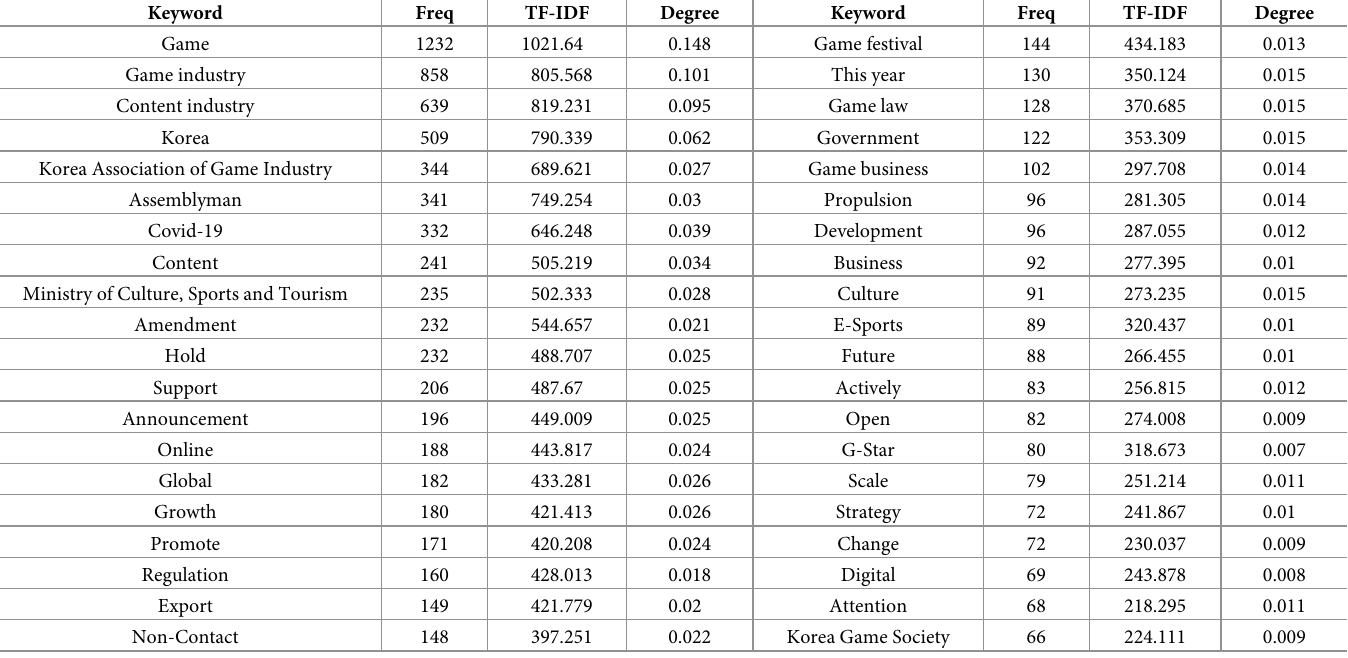
Table 4. The top 40 important keyword of game industry after COVID-19 outbreak in 2020.